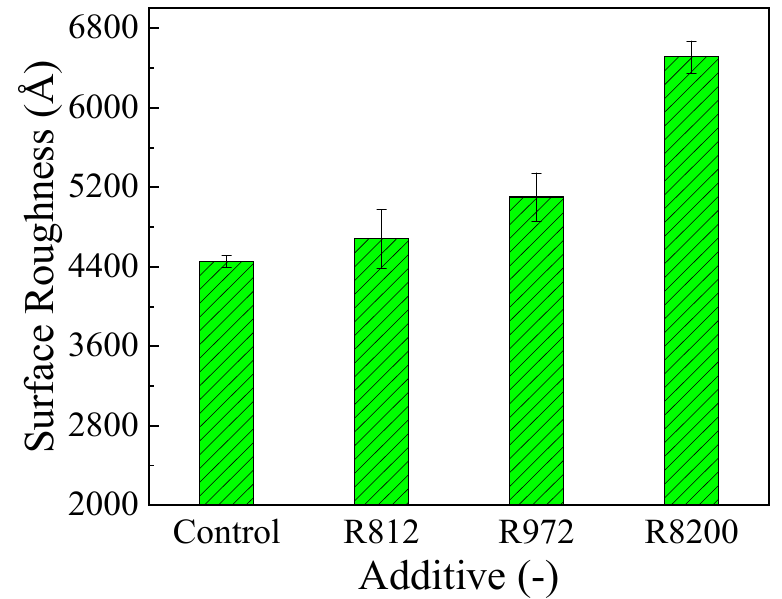
Figure 12. Surface roughness profile of powder samples films.